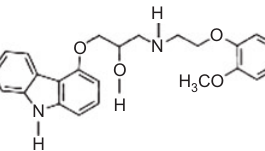
Figure 1 Chemical structure of carvedilol.